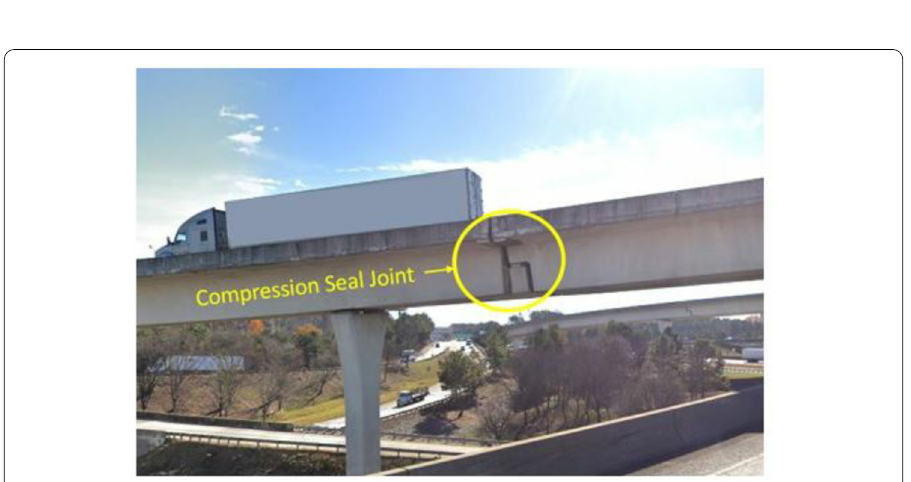
Figure 2 Potential damage. Pier deterioration caused by beam-joinery damage